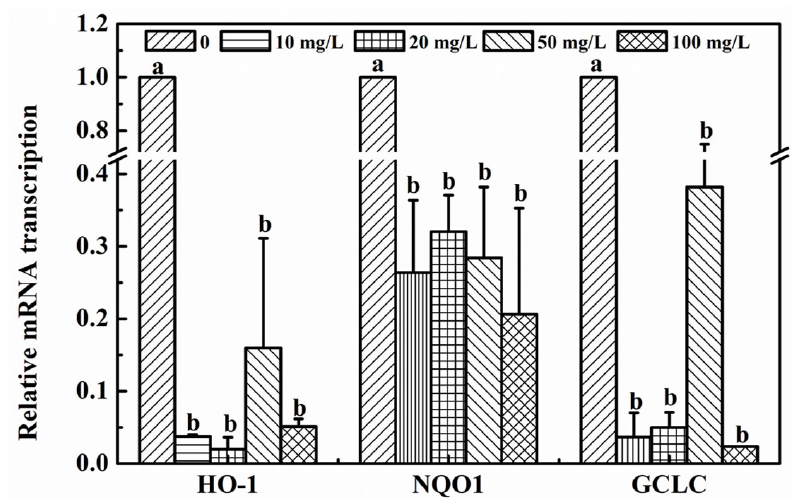
Figure 3. The effect of different concentrations of 2,6-DCBQ on the gene expression of HO-1, NQO1 and GCLC of mice, after 30 d of exposure. Values are plotted as the mean ± SD, and the lowercase letters above the bars represent a significant difference between groups.